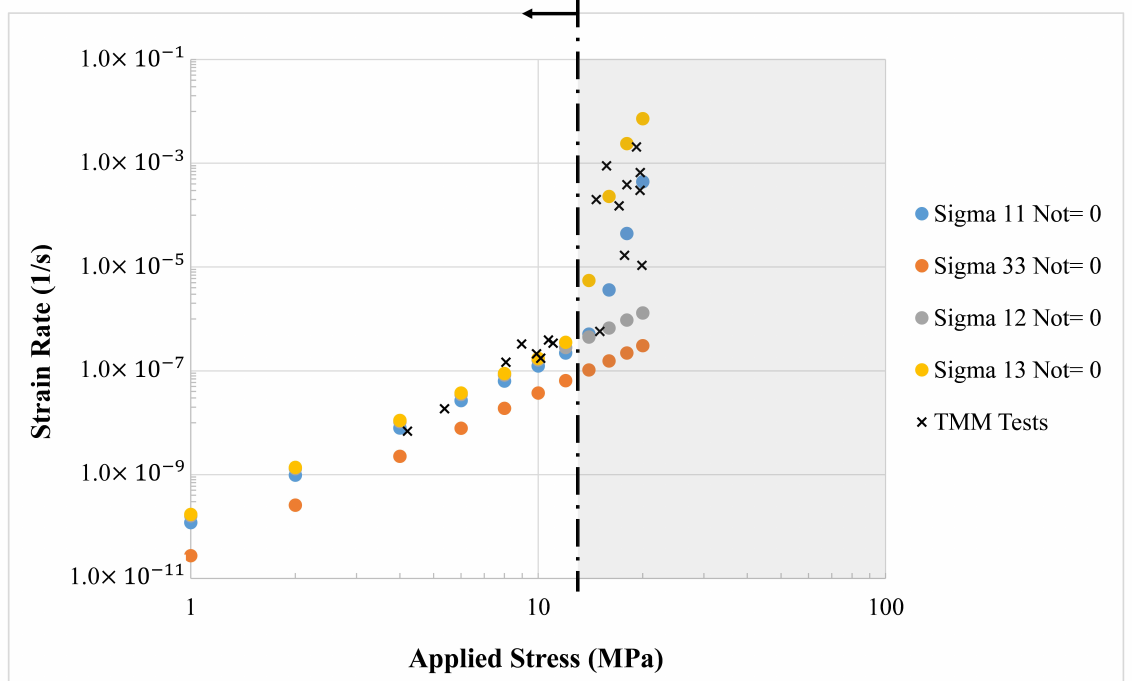
Figure 2. Strain rates along the loading directions calculated from the CV model.